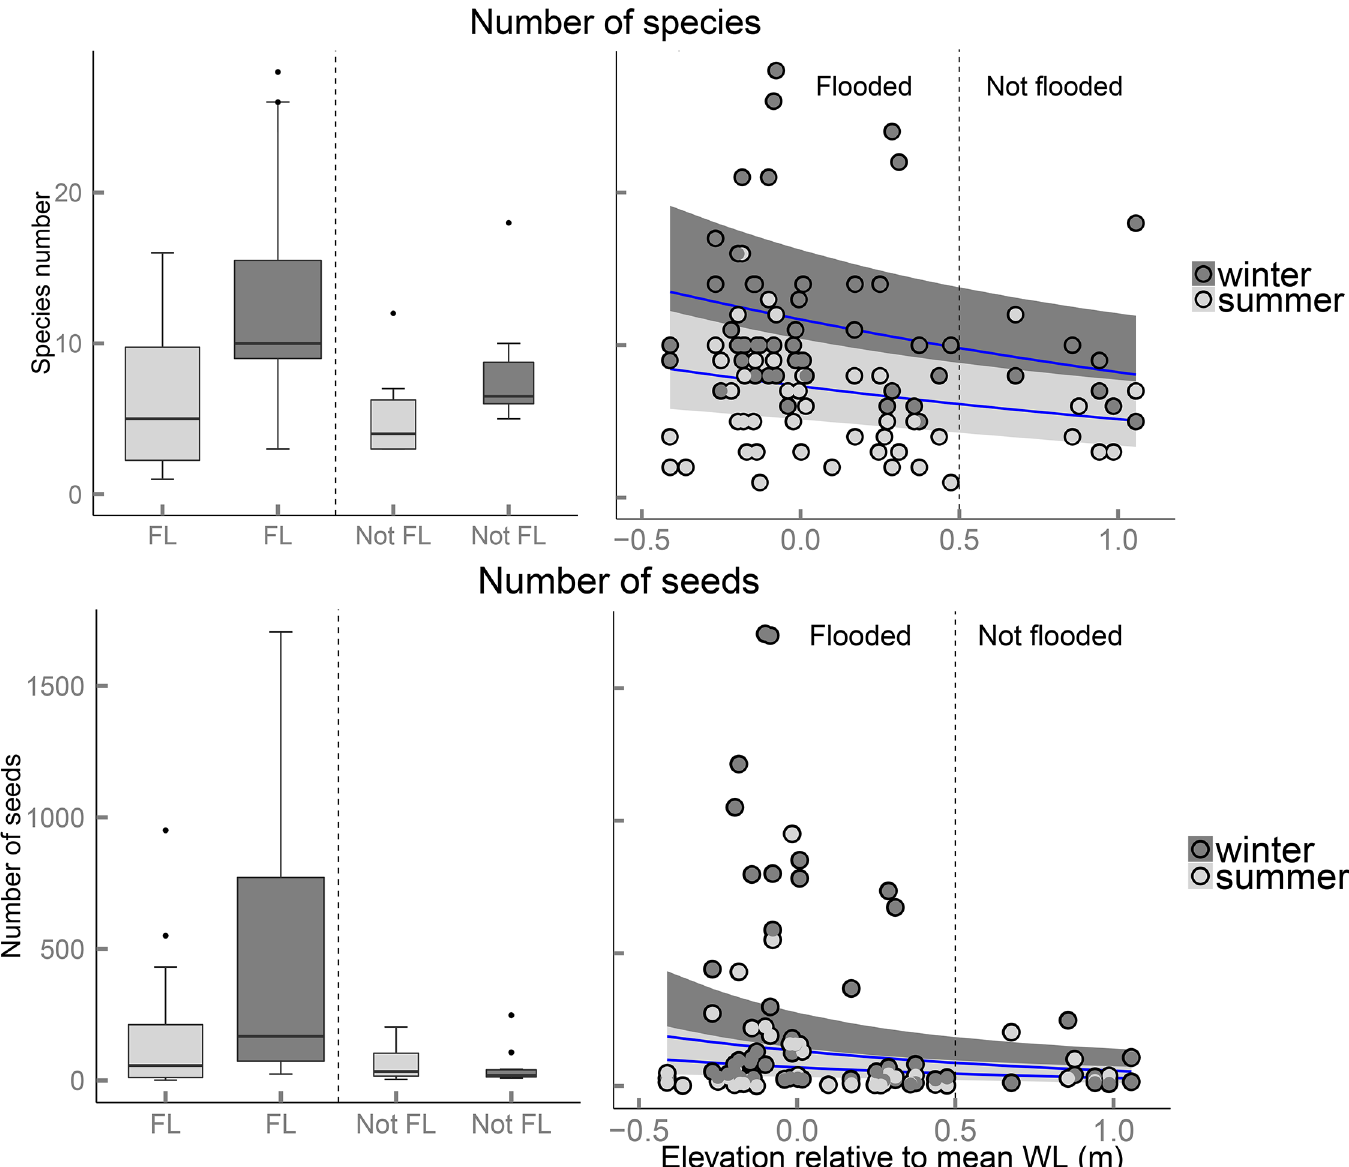
Fig 3. The effectsof flooding and season on the number of species of deposited seeds (upper panels) and number of seeds (lower panels). A comparisonof flooded(FL) and non-floodedseed traps (Not FL) is given in the left panels(box widths proportional to numberof seed traps). The effect of seed trap elevationrelative to mean water level is given in the right panels (negative values represent seed traps below the averagewater level, positive values represent seed traps above it). Summer and winter data are displayedin different greyscales.In the right panels, blue lines represent modelled relationshipsbetweenfield data (circles) and the explanatoryvariablesseason and elevation, as analyzedin negativebinomialGLMMs. Grey ribbonsindicate the 95% confidenceintervals (based on fixed effects only).